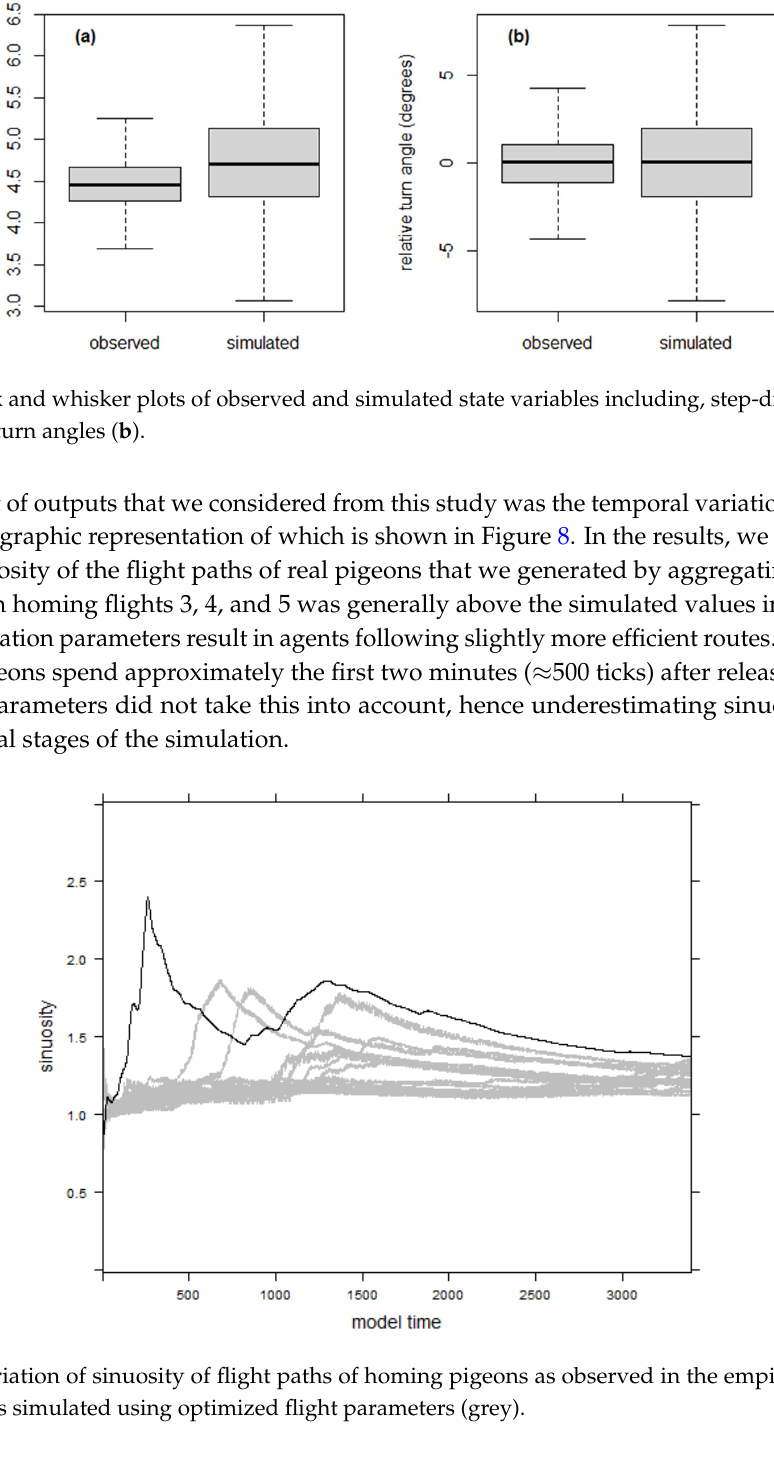
ISPRS Int. J. Geo-Inf. 2017 , 6 , 27 12 of 18 Figure 6. Loops in flight paths as reproduced by optimized model parameters ( a ); loops as captured in the empirical data ( b ). A statistical comparison of the simulated state variables of step distance and relative turn angles was achieved in two parts; firstly, we used box and whisker plots to represent the median and the distribution of the observed and simulated variables as shown in Figure 7. We noted that whereas the median of the observed value of step distance was approximately 4.5 m, the median of the simulated step distance was slightly higher at approximately 4.7 m. The mean values of the observed and simulated values of relative turn angles during navigation were in both cases approximately equal to 0°. Additionally, for both the step distance and the relative turn angles, the range of simulated values was slightly wider in comparison to the range of the observed values (3 m to 6.4 m against 3.6 m to 5.3 m the case of step distances and − 10° to 10° against − 5° to 5° in the case of relative turn angles). Results of